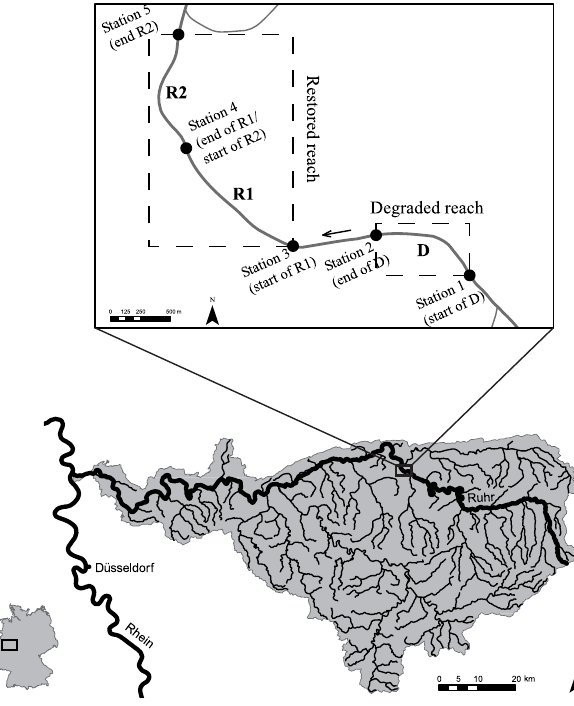
Figure 1. Location of the study site in the upper catchment of the river Ruhr in Germany. Stations represent start and end of the inves- tigated river reaches (degraded, first restored and second restored reach).